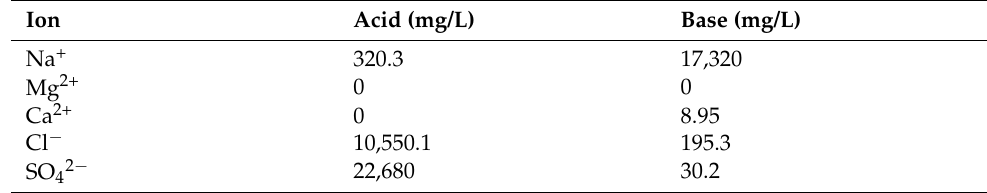
Table 7. Main ions in the base and acid solution.